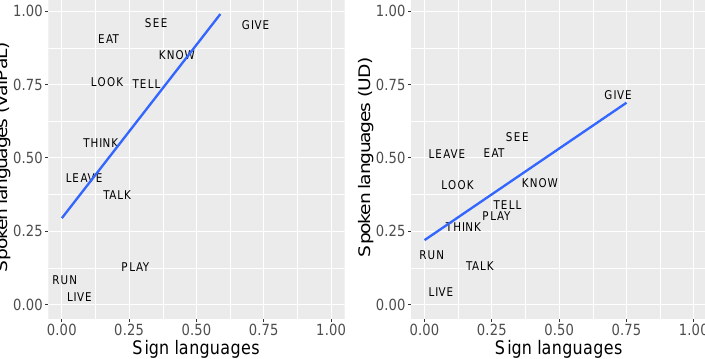
Figure 8: The transitivity proportion of the 12 ValPaL meanings compared for two language group pairings, SL–ValPaL (left); SL–UD (right), without locative arguments for the sign language group. The blue lines show a fitted linear regression for each